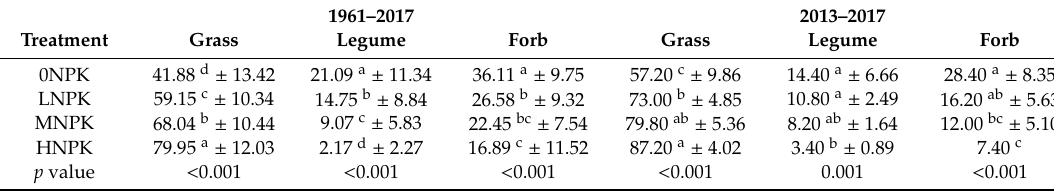
Table 4. Mean cover (%) of plant functional group before the first cut during 1961–2017 and 2013– 2017 period.